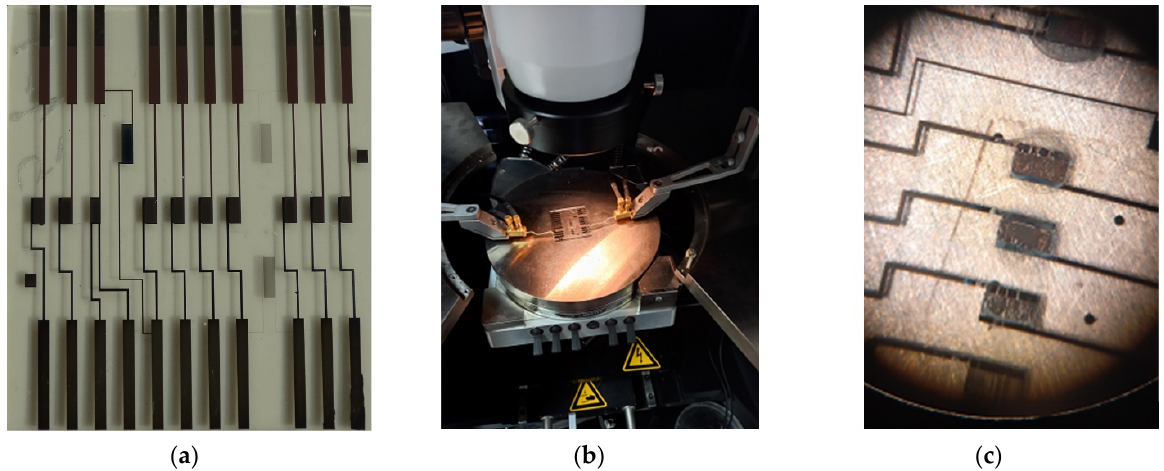
Figure 5. Experimental arrangement for study of field and photofield emission: photo of the layout with emission structures “Mo-DLC” ( a ); experimental setup for measuring the I–V characteristics with a mock-up structure “Mo-DLC-GNS“ ( b ); photo of the emission zone of the layouts of the “Mo-DLC-GNS“ structure, obtained using an optical microscope of the probe station ( c ).